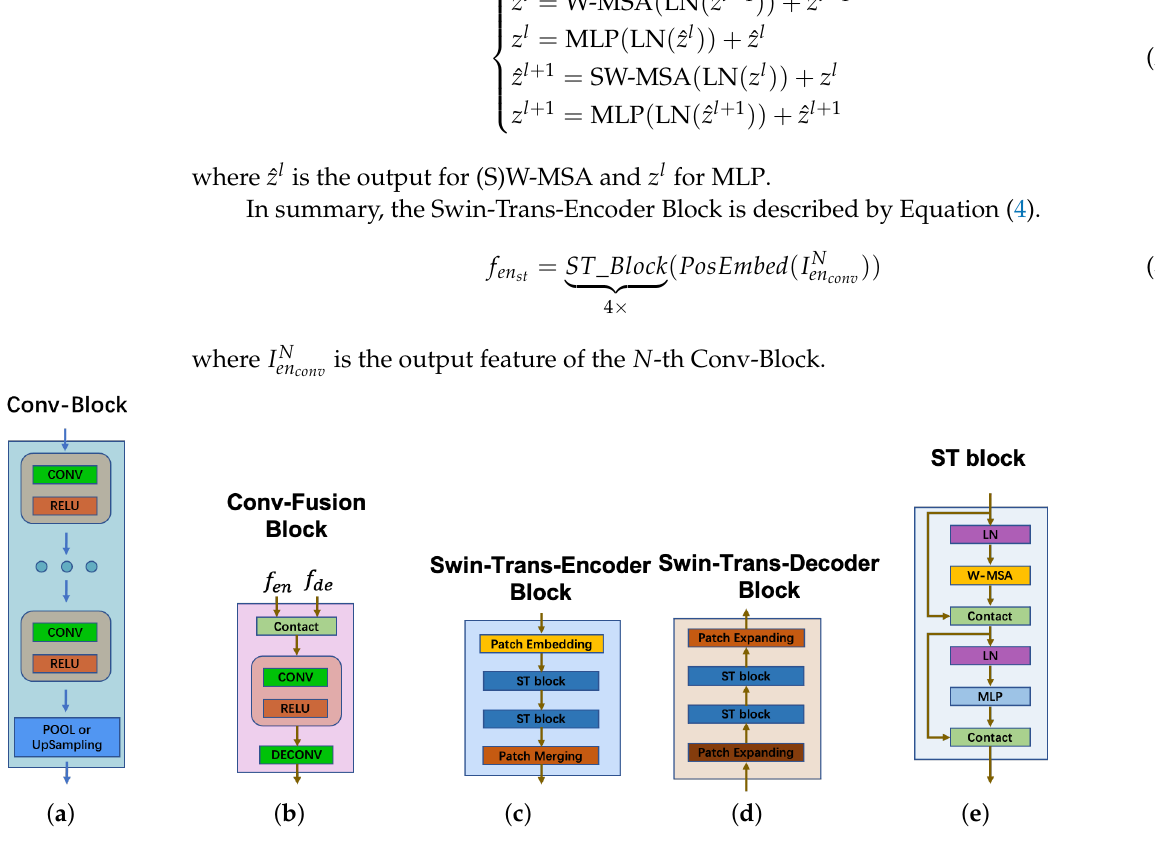
Figure 3. Subfigure ( a ) is Conv-Block, which consists of M convolution-activation blocks. The output in Encoder Module (EM) is the pooled feature, but the output in Decoder Module (DM) is the upsampling feature. Subfigure ( b ) is Conv-Fusion Block, which fuses the encoding feature and the decoding feature by concatenating, and then uses convolution fusing deeply. Subfigure ( c ) is Swin-Trans-Encoder Block, which uses Patch Embedding for image slicing and positional encoding, and uses two swin transformer blocks to extract features containing relationships, and uses Patch merging to merge image slices. Subfigure ( d ) is the Swin-Trans-Decoder Block, which uses the same number of swin transformer blocks as the Swin-Trans-Encoder Block. Subfigure ( e ) is the architecture of the swin transformer